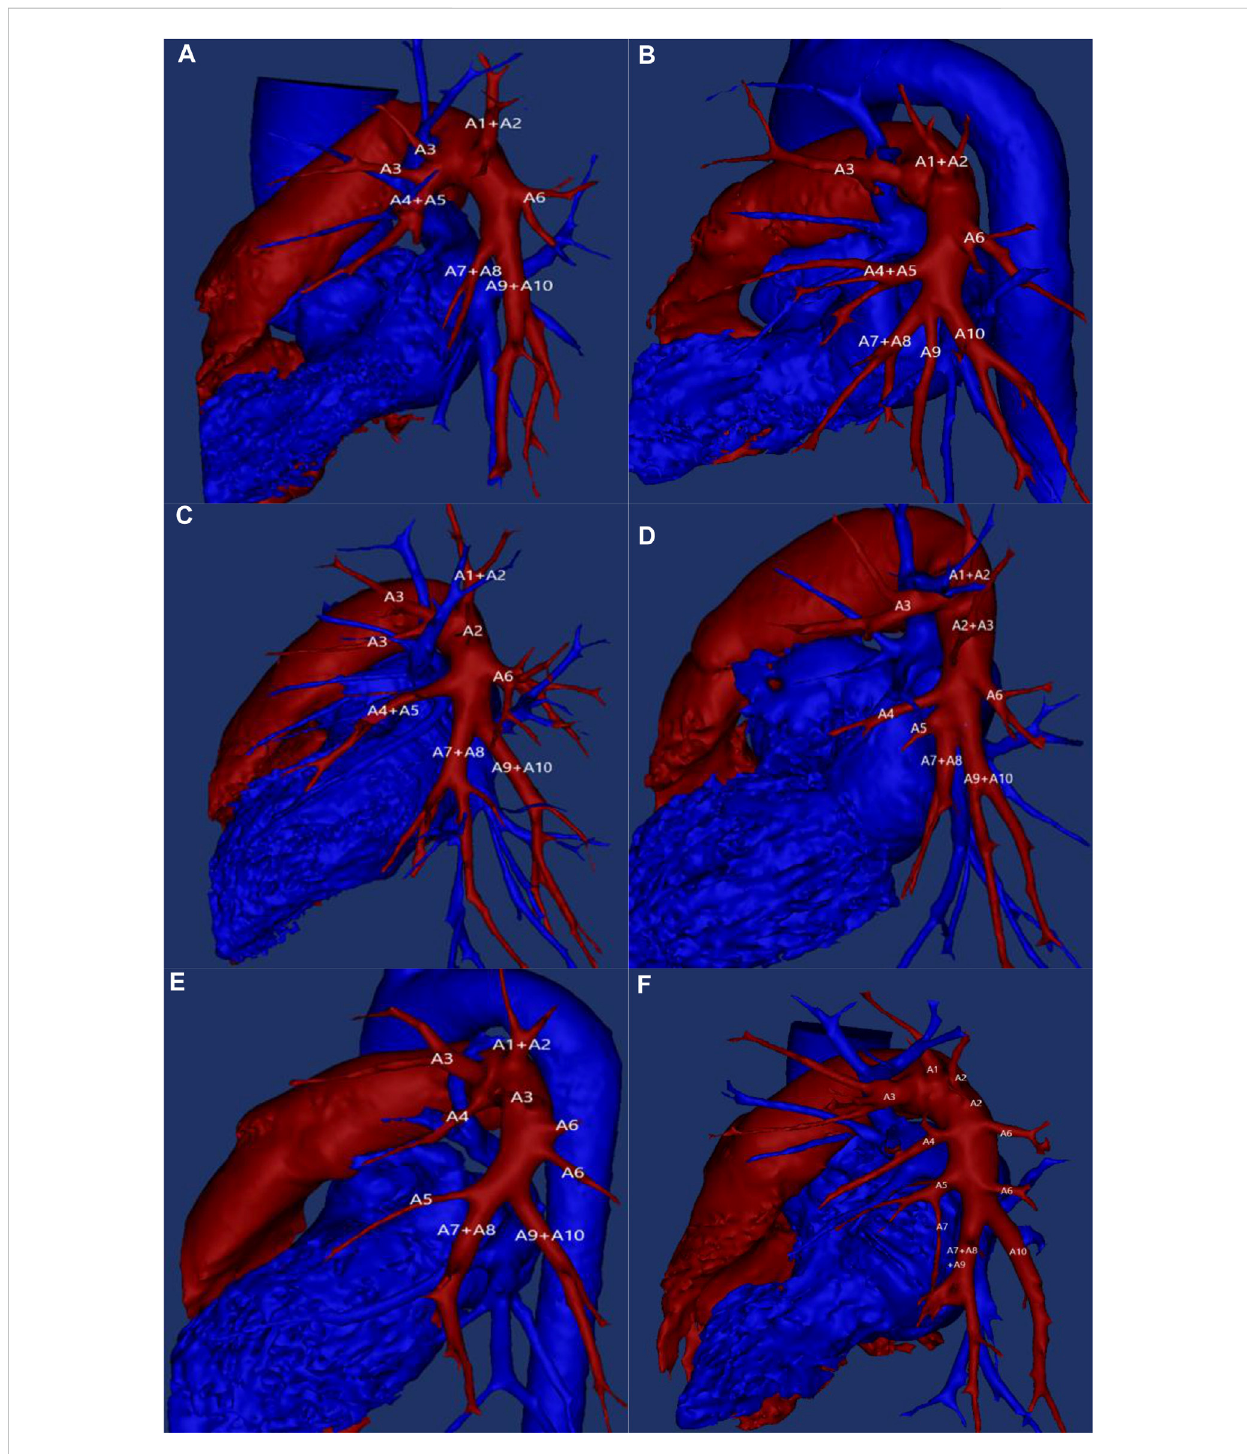
FIGURE 1 Example of left pulmonary artery vascular variation. A1: Apical segmental artery; A2: Posterior segmental artery; A3: Anterior segmental artery; A4: Superior lingual segmental artery; A5: Inferior lingual segmental artery; A6: Inferior lobe superior segment artery; A7: Medial basal segment artery; A8: Anterior basal segment artery; A9: lateral basal segment artery; A10: posterior basal segment